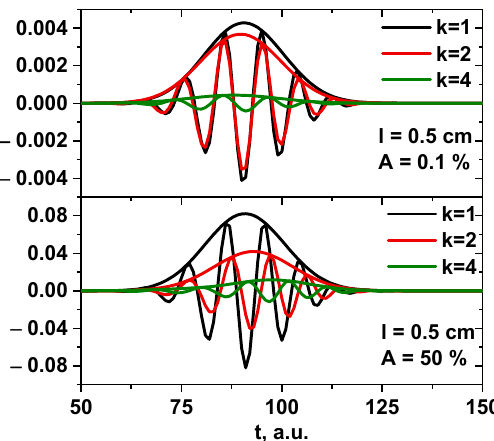
a given velocity of 10 km/s. Figure 30 depicts the obtained signals. The signal amplitude for the poloidally stretched filament (red and green lines) decreased the more it was stretched compared to the circular filament (black line). It can also be said that while in the linear case (top) there was no delay between the signals, in the non-linear case (bot- tom) a time off-set was clearly visible where the stretched filament signal developed sev- eral ms later.